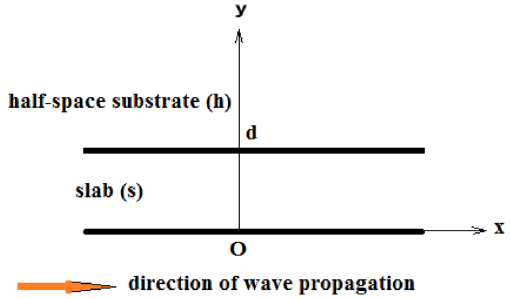
Figure 1. Geometry of the